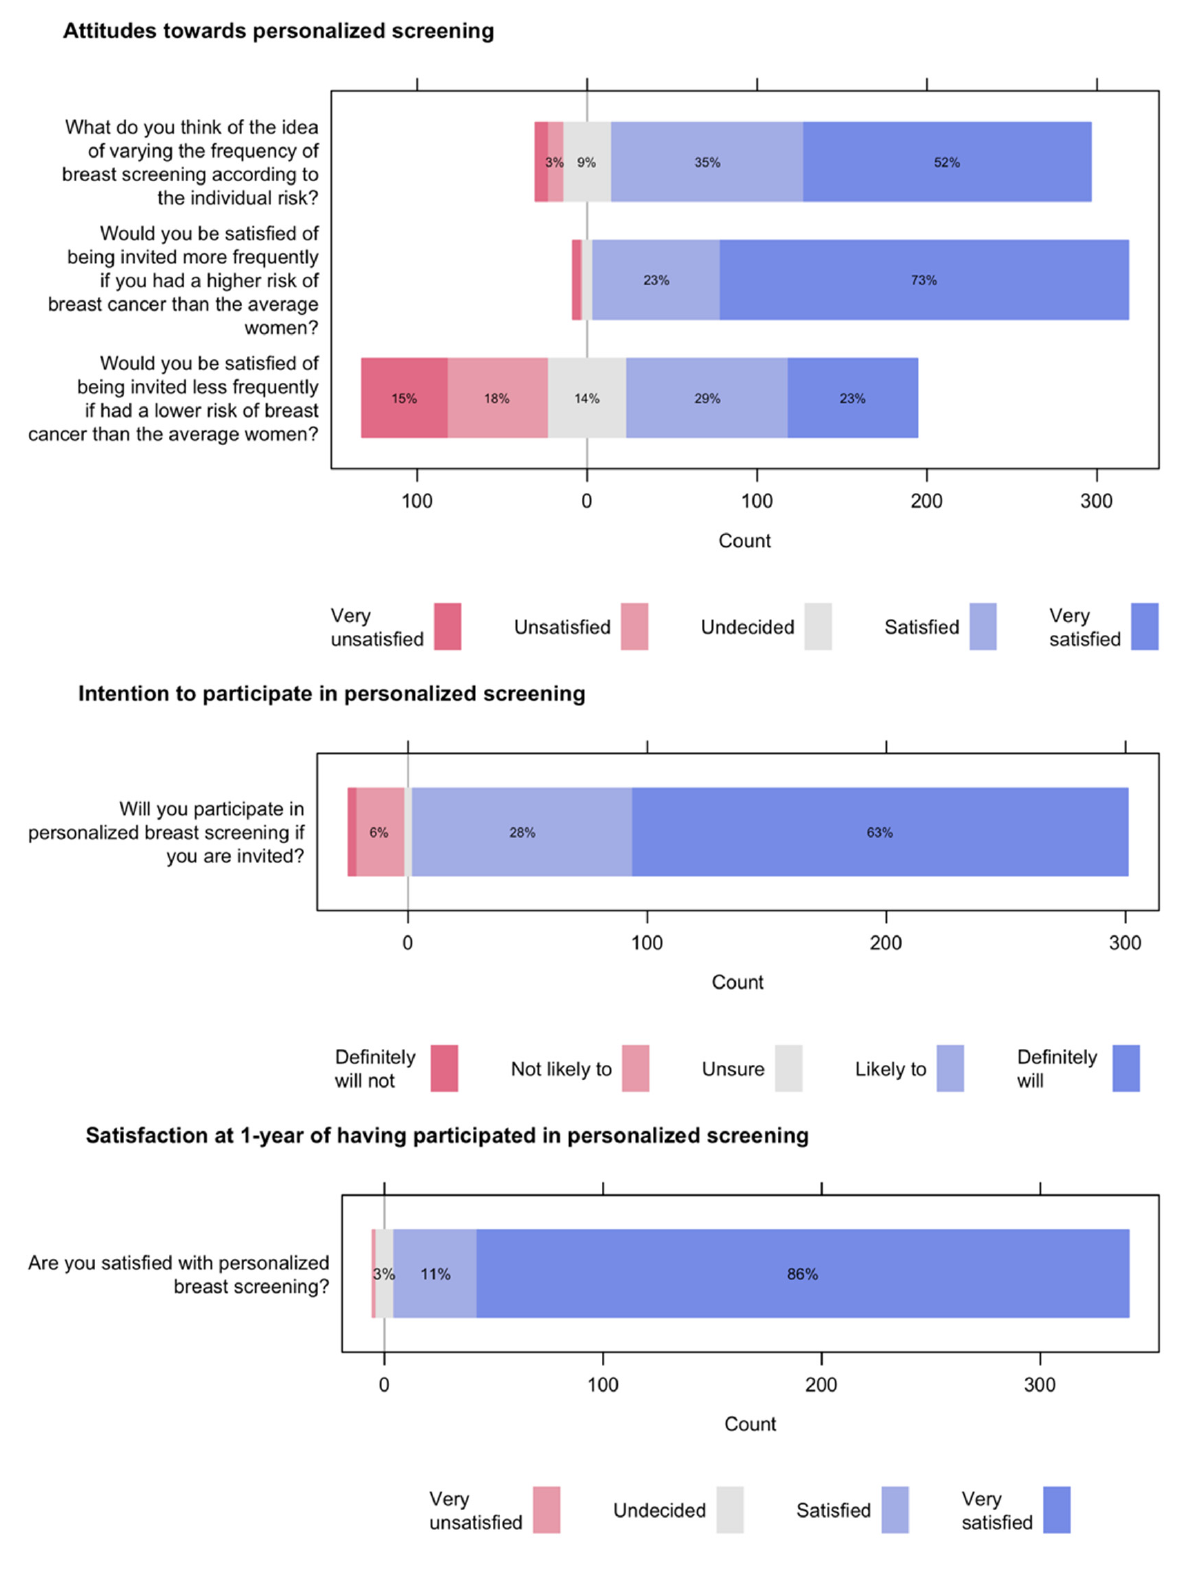
Figure 3. Likert scale distribution for the primary outcomes. (Note: Percentage values are rounded and values below 3% are not printed. Therefore, the sums may not add up to 100%.)